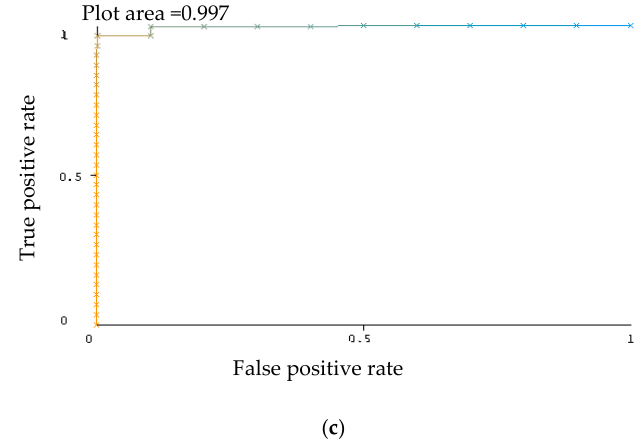
Figure 6. Receiver operating characteristic (ROC) graph activity of ensemble classifier bagging ( a ), Adaboost ( b ), random subspace ( c ) with k-NN classifier using 10-fold cross validation method Dataset 1.